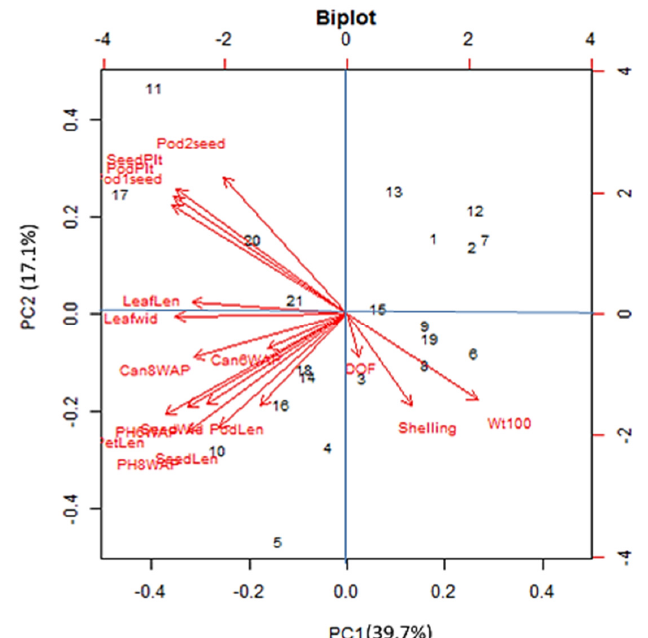
Figure 4. Biplot display of the relationship between the grouped accessions in the twenty-one countries and seventeen quantitative